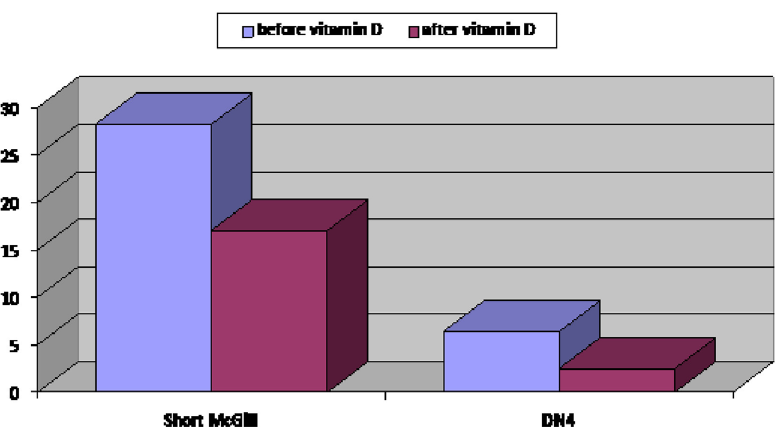
Figure 1. Neuropathic pain score assessed by Douleur Neuropathic 4 score and severity of peripheral neuropathy assessed by the Short-Form McGill Pain Questionnaire score of group A (prediabetic patients with peripheral neuropathy) before and after vitamin D supplementation.